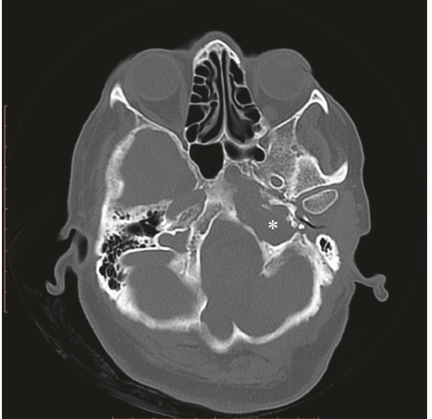
Figure 2: Axial CT image with the softtissue window settings shows a low-density pouch herniated to the jugular foramen (∗) .